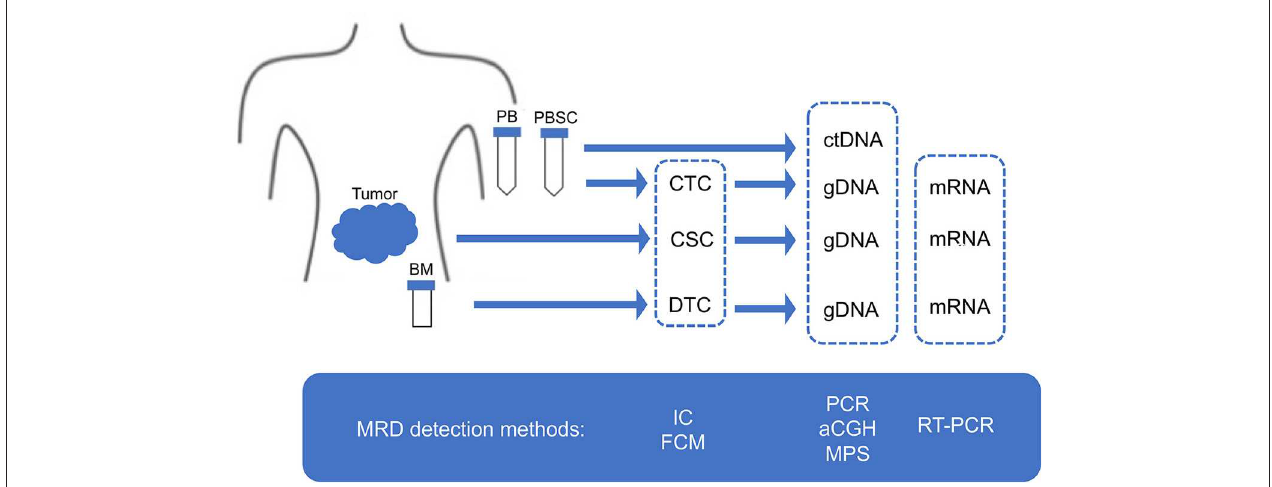
FIGURE 4 | MRD detection methods. MRD, minimal residual disease; CSC, cancer stem cell; CTC, circulating tumor cell; DTC, disseminating tumor cell; ctDNA, circulating tumor DNA; PB, peripheral blood; PBSC, peripheral blood stem cell; BM, bone marrow; IC, immunocytology; FCM, flow cytometry; PCR, polymerase chain reaction; aCGH, array comparative genomic hybridization; MPS, massively paralleled sequencing; RT-PCR, reverse transcriptase-PCR.